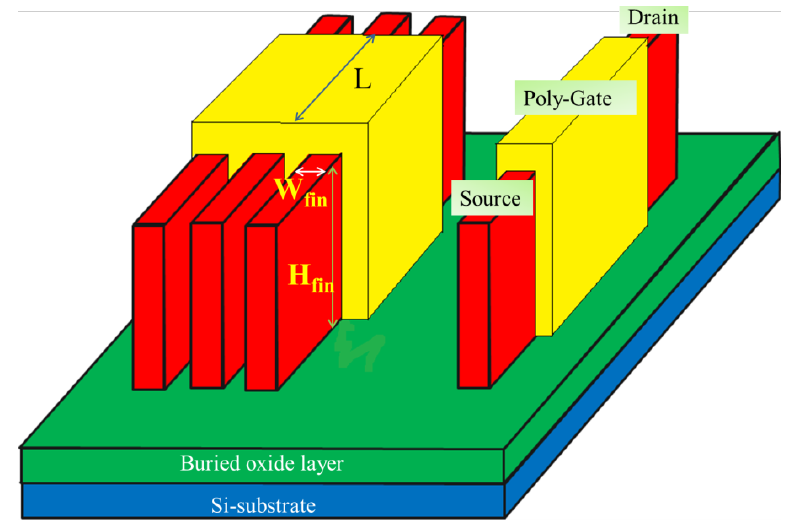
Figure 1. The scheme of FinFETs with single and multi-fin contours on SOI wafer.